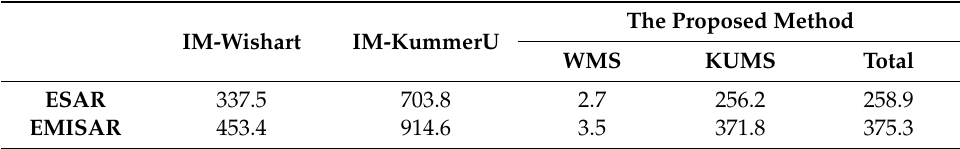
Table 2. Execution time comparison of different methods (in